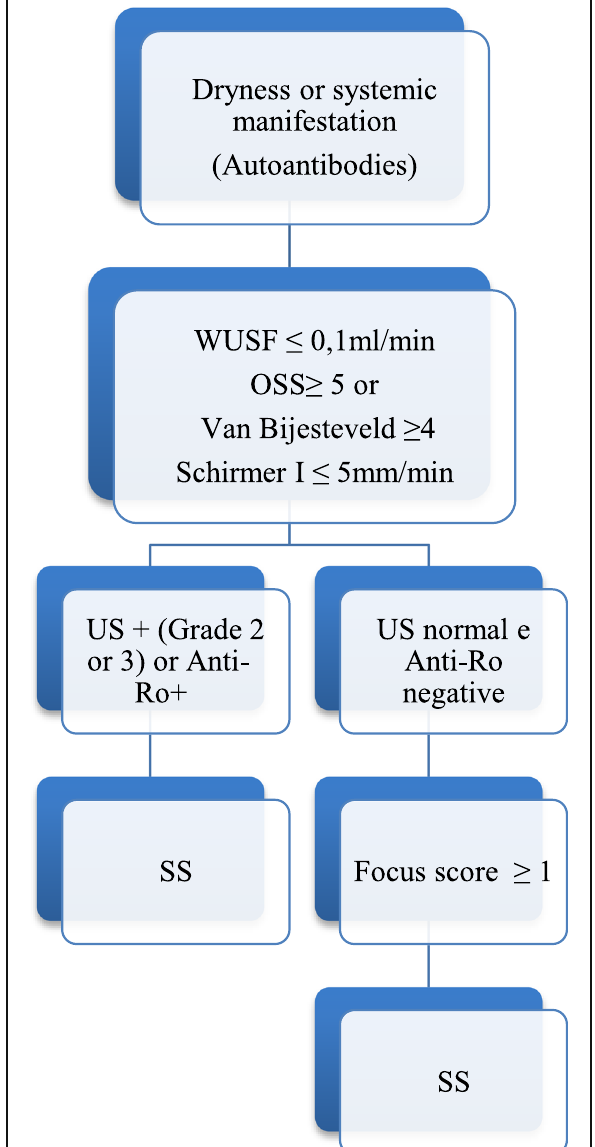
Fig. 2 Diagnosis of Primary Sjogren ’ s